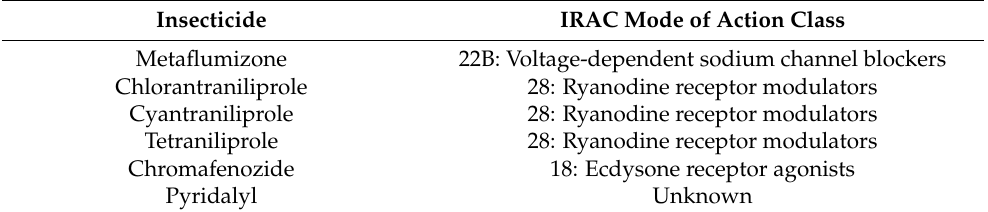
Table 2. Insecticides tested against field-collected S. litura